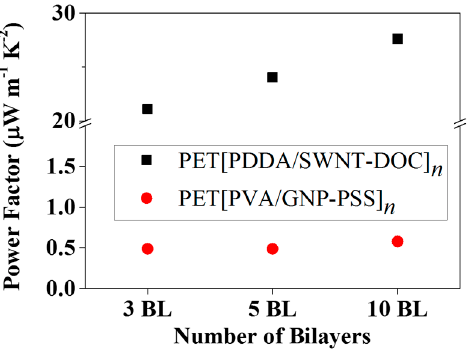
Figure 6. Thermoelectric power factor of PET[PDDA/SWNT-DOC] n ( n = 3, 5, 10) and PET[PVA/GNP-PSS] n ( n = 3, 5, 10) LbL thin films.